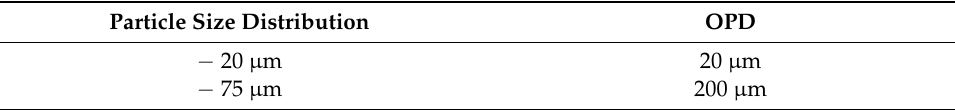
Table 2. Optical penetration depth of pure Ni